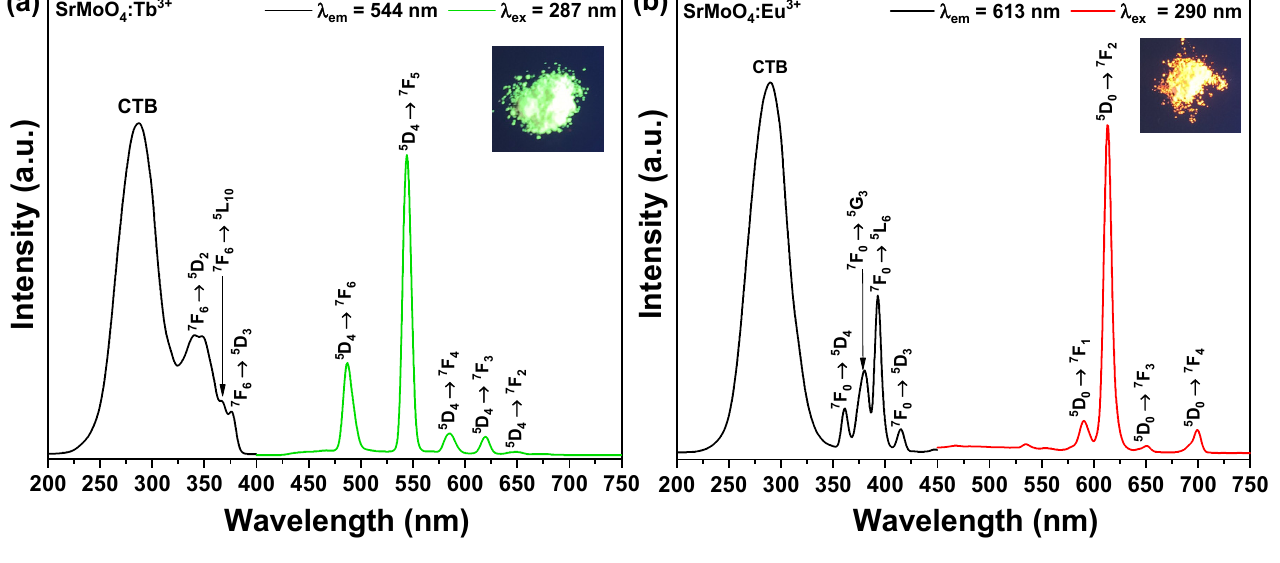
Figure 4. PLE and PL spectrum of ( a ) SrMoO 4 :Tb 3+ , ( b ) SrMoO 4 :Eu 3+ phosphors.